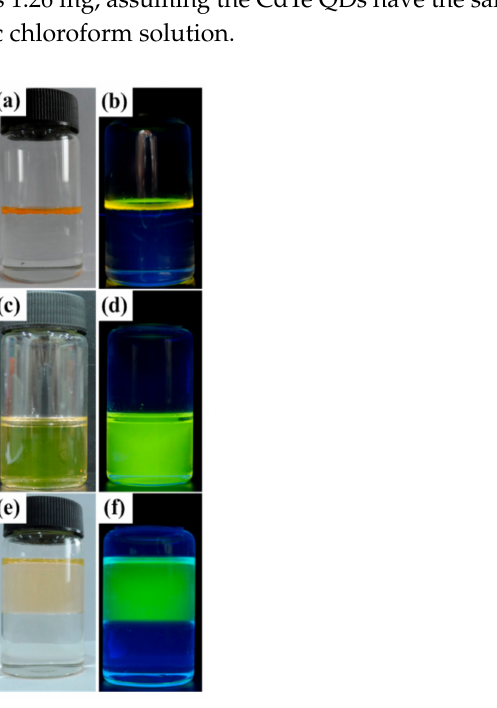
Figure 3. Encapsulation of CdTe QDs from aqueous phase (upper layer) into chloroform phase (down layer) by HPAMAM–DA and release of CdTe QDs into an aqueous solution (upper layer) illustrated by photographs made under daylight ( a , c , e ) and a UV lamp ( b , d , f ). Picture ( a ) and ( b ): CdTe QDs emitting yellow green light in an aqueous phase; picture ( c ) and ( d ): CdTe QDs encapsulated by HPAMAM–DA in a chloroform phase; picture ( e ) and ( f ): released CdTe QDs in an aqueous solution emitting green light.